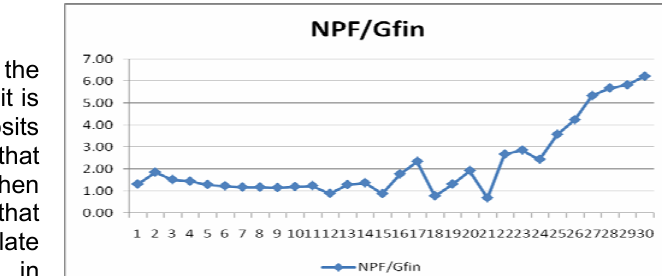
Figure-01: Non-Performing Financings/Gross